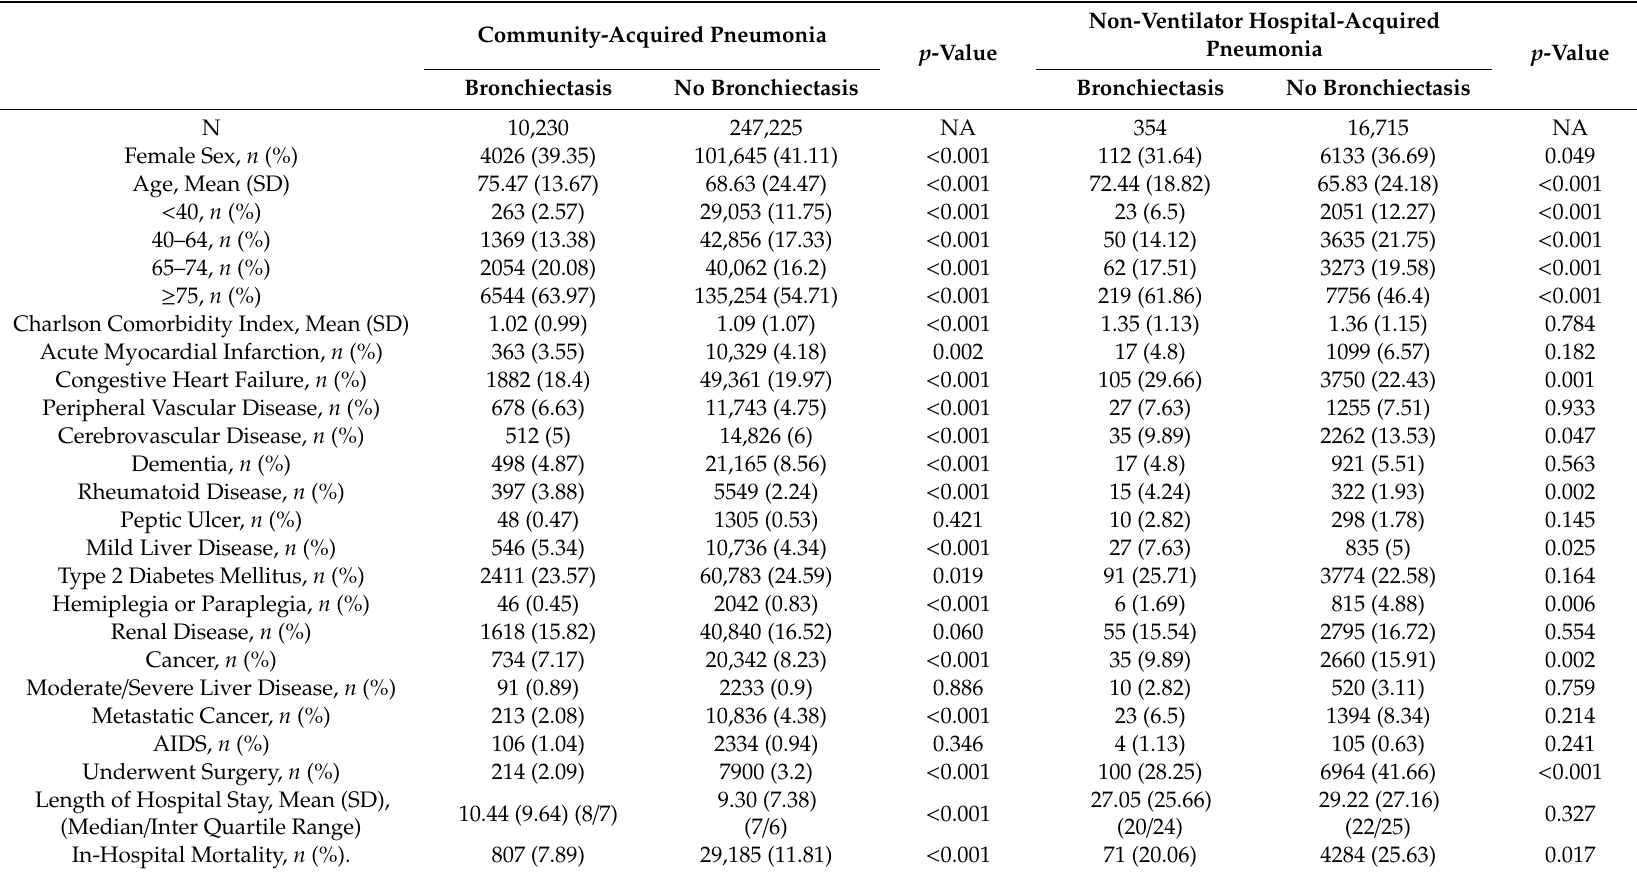
Table 1. Clinical characteristics and in-hospital outcomes of patients hospitalized with community-acquired pneumonia (CAP) and non-ventilator hospital-acquired pneumonia (NV-HAP) in Spain (2016–17) according to the presence of concomitant